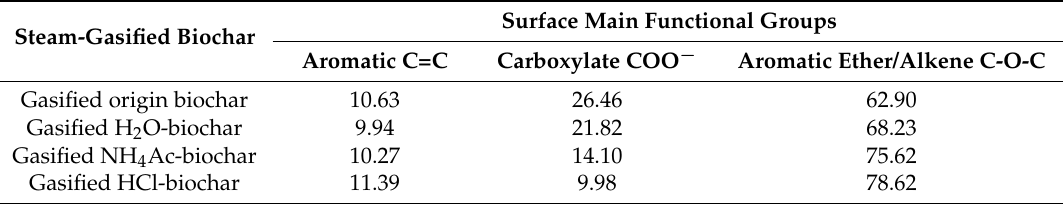
Figure 9. FTIR analysis of steam-gasified biochar with different chemical fractions. The result of the curve-fitting FTIR analysis on O-containing functional groups can be seen in Table 3. Table 3. FTIR analysis of O-containing functional groups on steam-gasified biochar